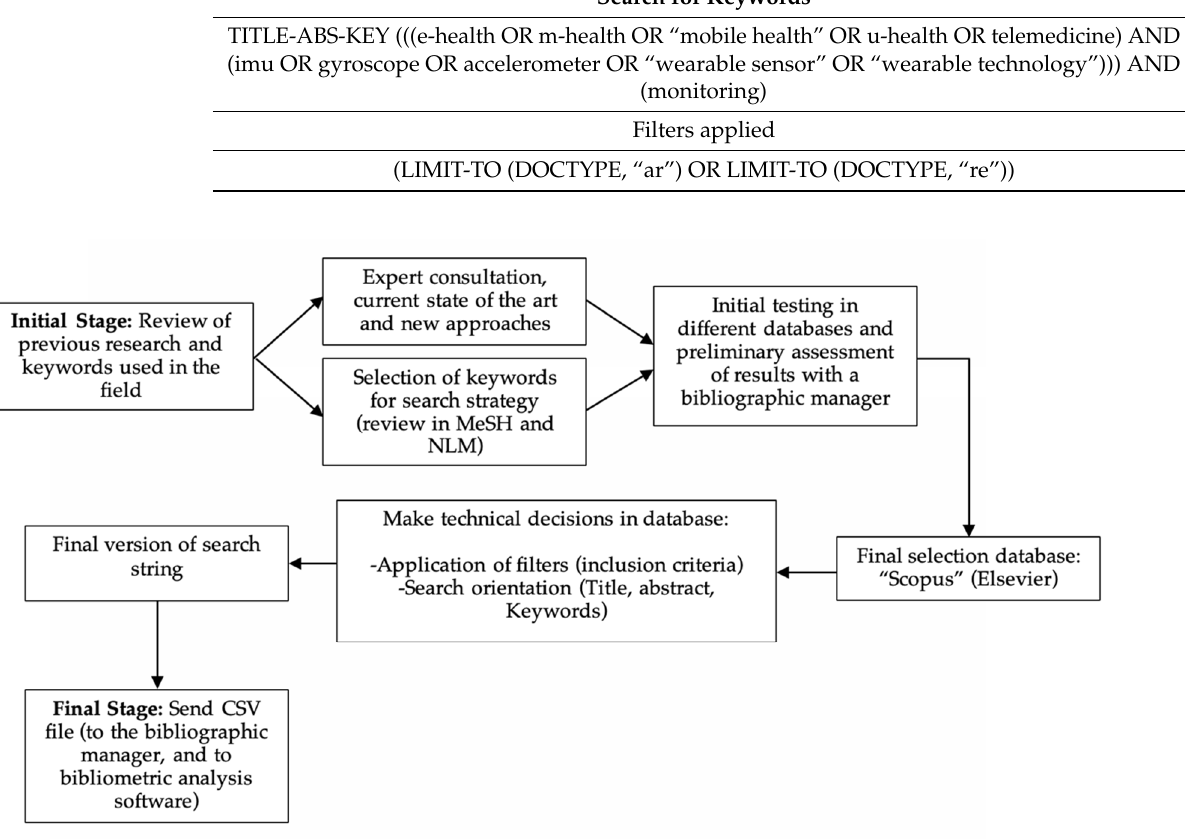
Figure 2. UML diagram of the stages followed in the search strategy.